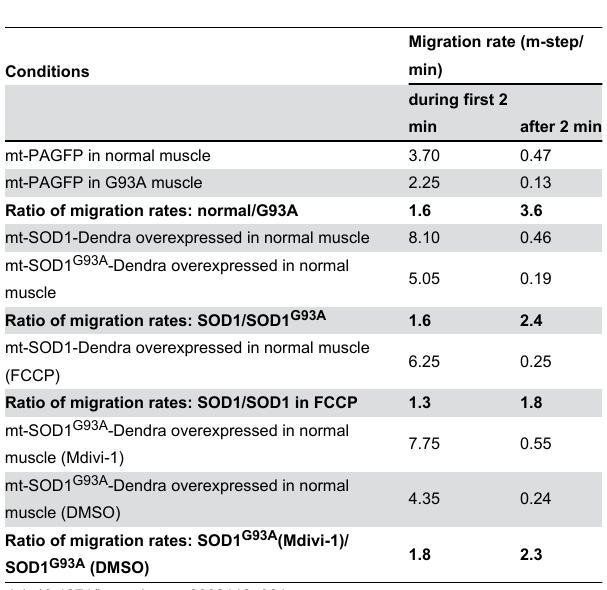
Table 1. Migration rates of fluorescent proteins after the photoactivation.